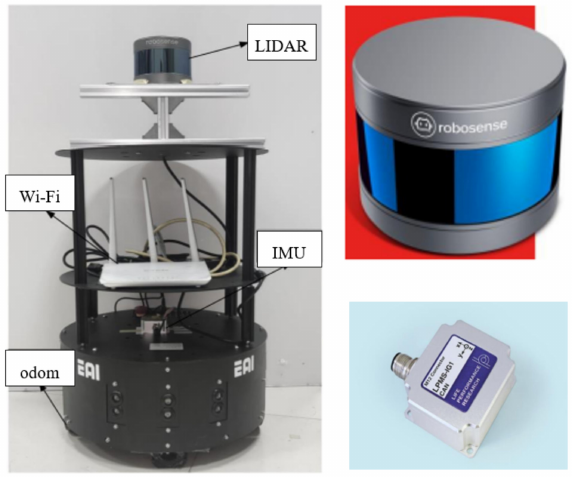
Figure 11. Mobile experiment